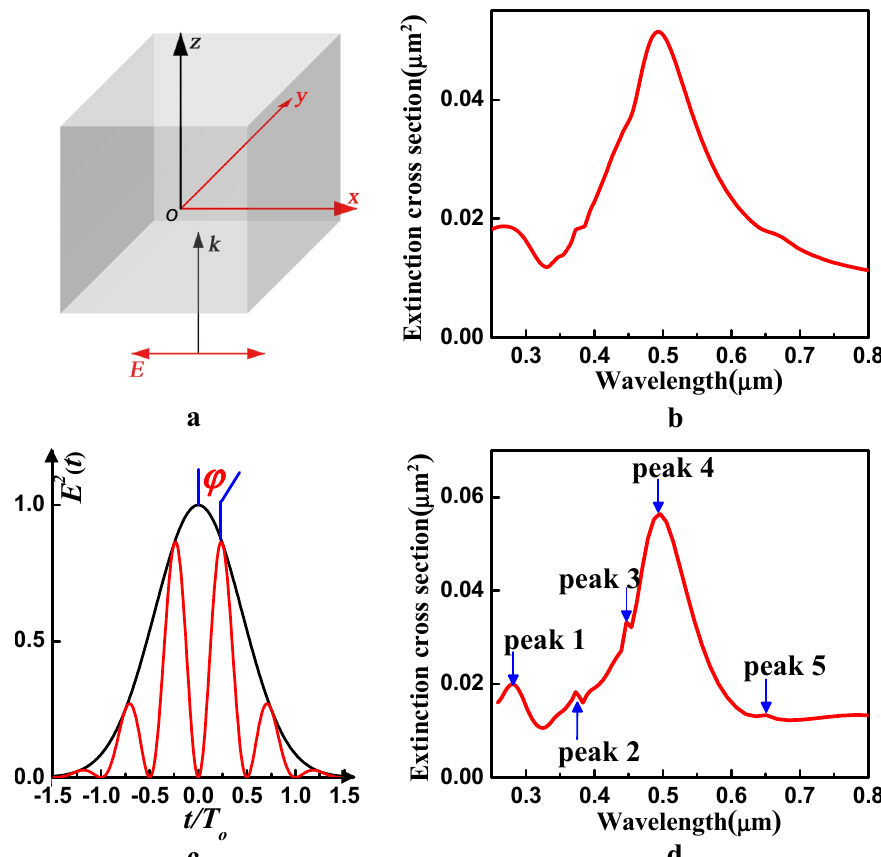
Figure 1. ( a ) Schematic configuration of the nanocube and the coordinate system for the simulation. ( b ) Calculated optical extinction cross section spectra for the Ag nanocube embedded in an air background with an edge length of 90 nm driven by a continuous wave light. ( c ) Schematic of an ultrashort pulse. ϕ is the CEP, T 0 is the time period of the laser field. ( d ) Calculated optical extinction cross section spectra for the Ag nanocube embedded in an air background with an edge length of 90 nm driven by an ultrashort